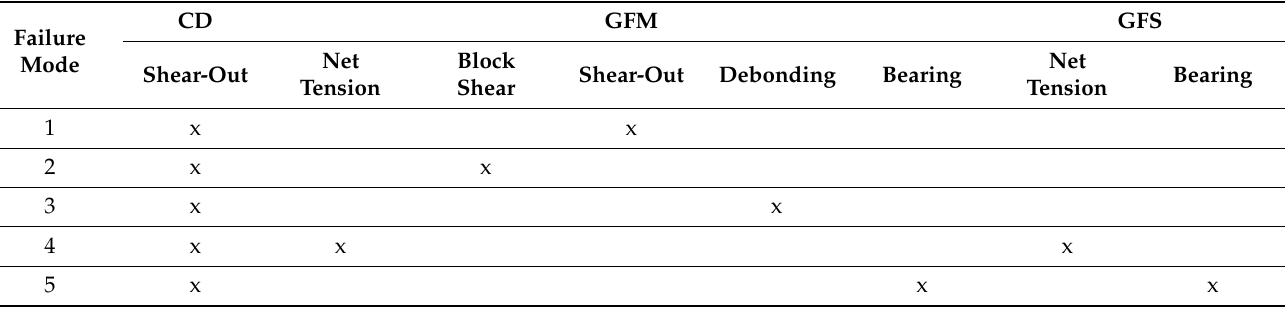
Table 4. Detail of failure mode in specimens.